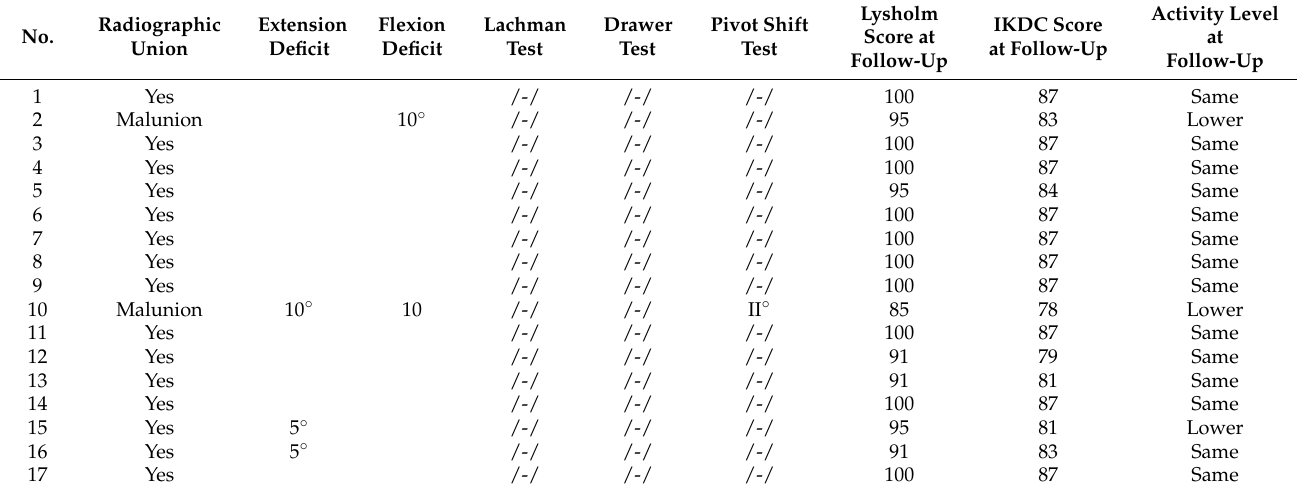
Figure 4. A 7.3-year-old girl with a right tibial eminence fracture-type IV according to Meyers–McKeever classification. Chronological: CT after injury, sagittal and coronal scans before surgery; CT before second surgery, sagittal and coronal scans (malunion of the tibial eminence with the elevation of its front edge of 6 mm). Table 2. Individual treatment